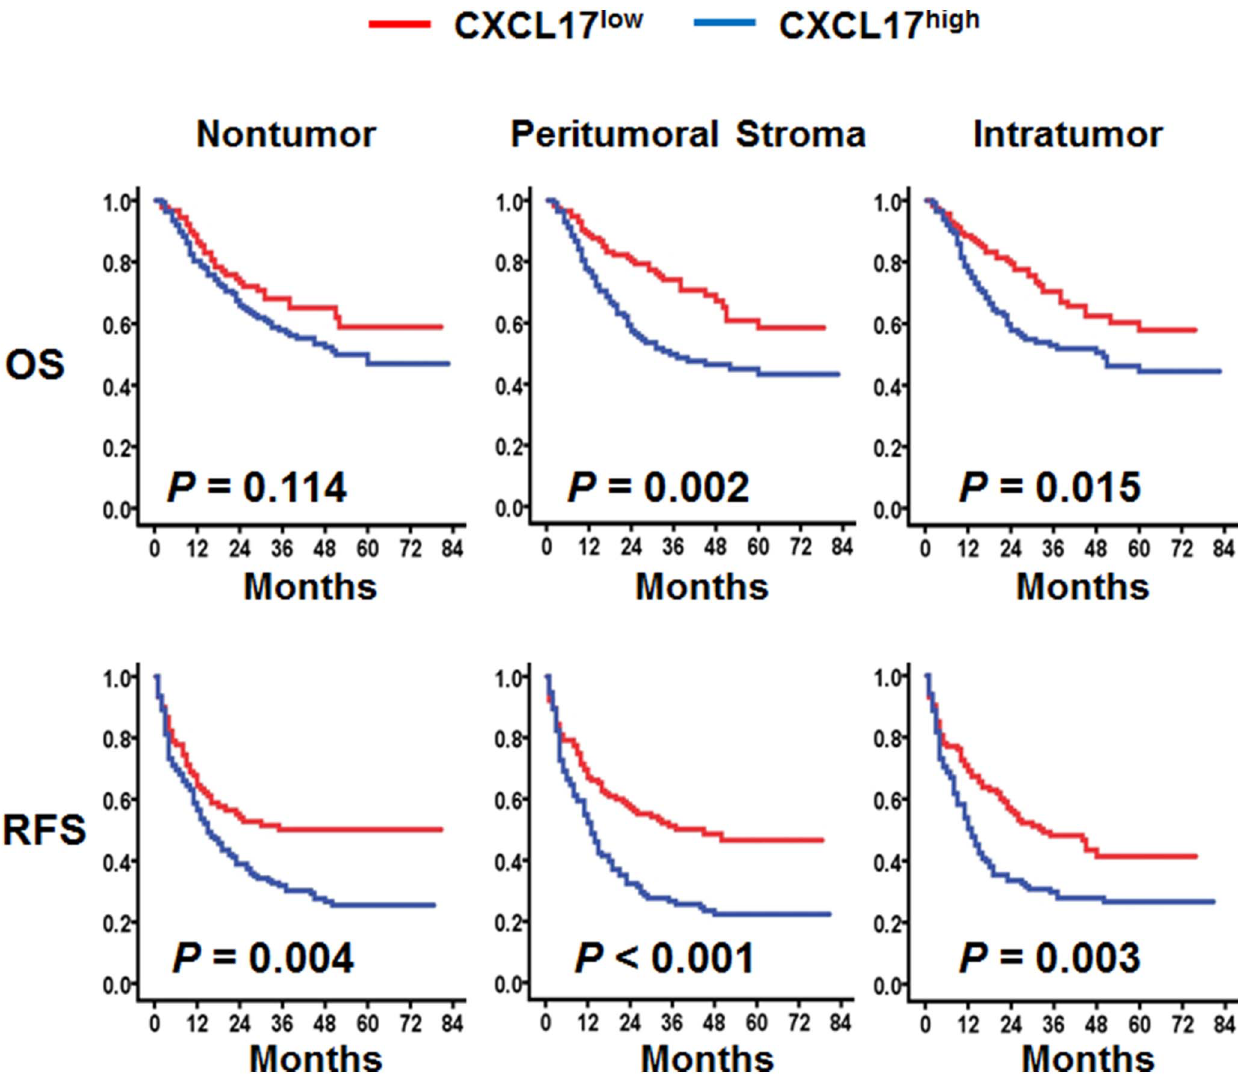
Figure 2. Accumulation of CXCL17-producing cells predicted poor survival in HCC. OS (top) and RFS (bottom) were estimated by the Kaplan-Meier method and compared using the log-rank test